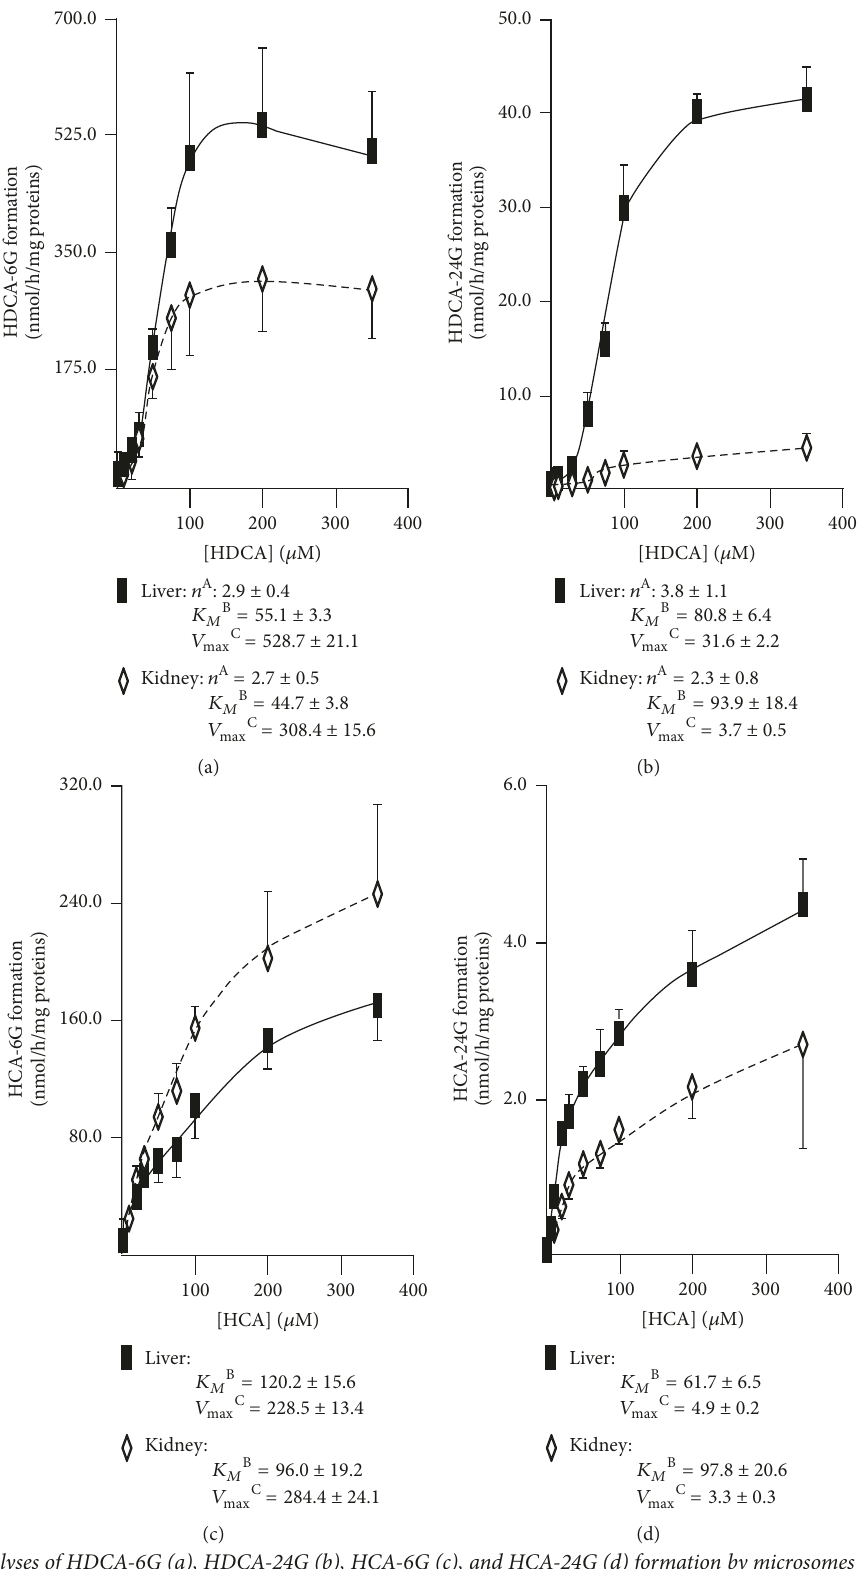
Figure 5: Kinetic analyses of HDCA-6G (a), HDCA-24G (b), HCA-6G (c), and HCA-24G (d) formation by microsomes from human liver and kidney. Human liver (black squares, pool of 50 donors) and kidney (white diamonds; pool of 8 donors) microsomes (10 𝜇 g) were incubated in the presence of increasing concentrations (1 to 350 𝜇 M) of hyodeoxycholic acid (HDCA, (a) and (b)) or hyocholic acid (HCA, (c) and (d)) for 2 hours at 37 ∘ C. The formation of HDCA-6G (a), HDCA-24G (b), HCA-6G (c), and HCA-24G (d) was analyzed by LC-MS/MS. For each panel, graphs represent the rate of product formation ( 𝑦 -axis) versus substrate concentration ( 𝑥 -axis) of two experiments performed in triplicate. The listed kinetic parameters were determined as indicated in “Materials and Methods.” A 𝑛 : Hill coefficient; B 𝐾 𝑀 : calculated Michaelis constant expressed as 𝜇 M; C 𝑉 max : calculated maximal velocity expressed as nmol/h/mg